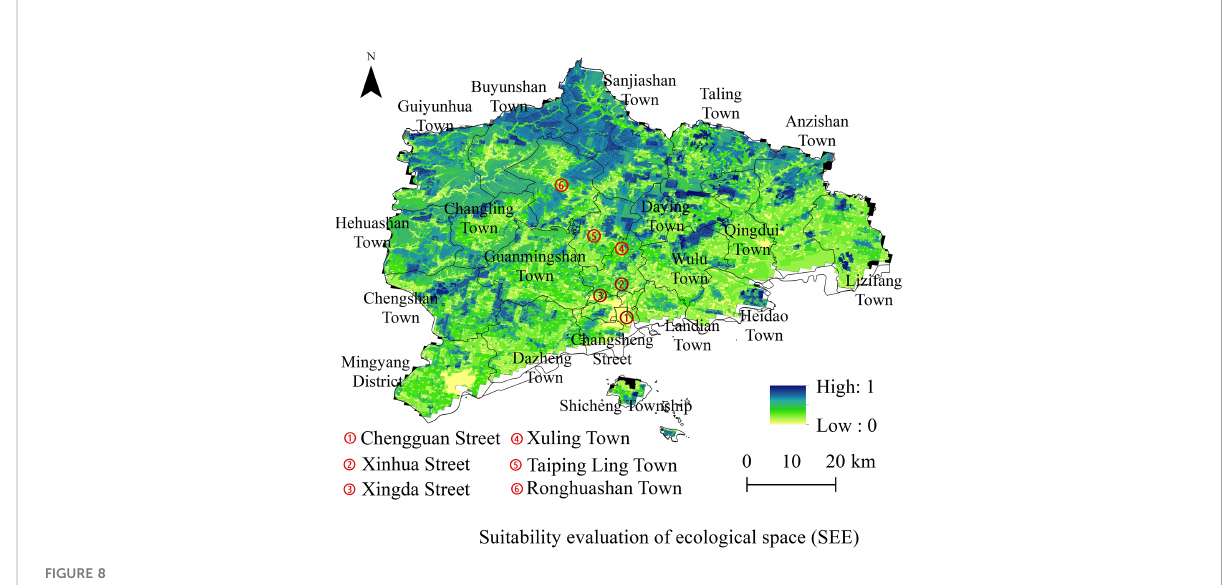
FIGURE 8 Evaluation of ecological space